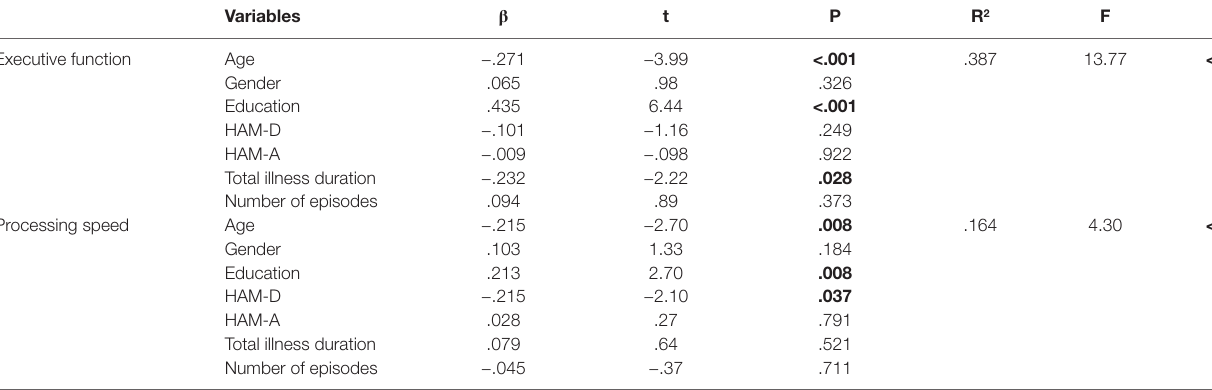
Bold values indicate statistical